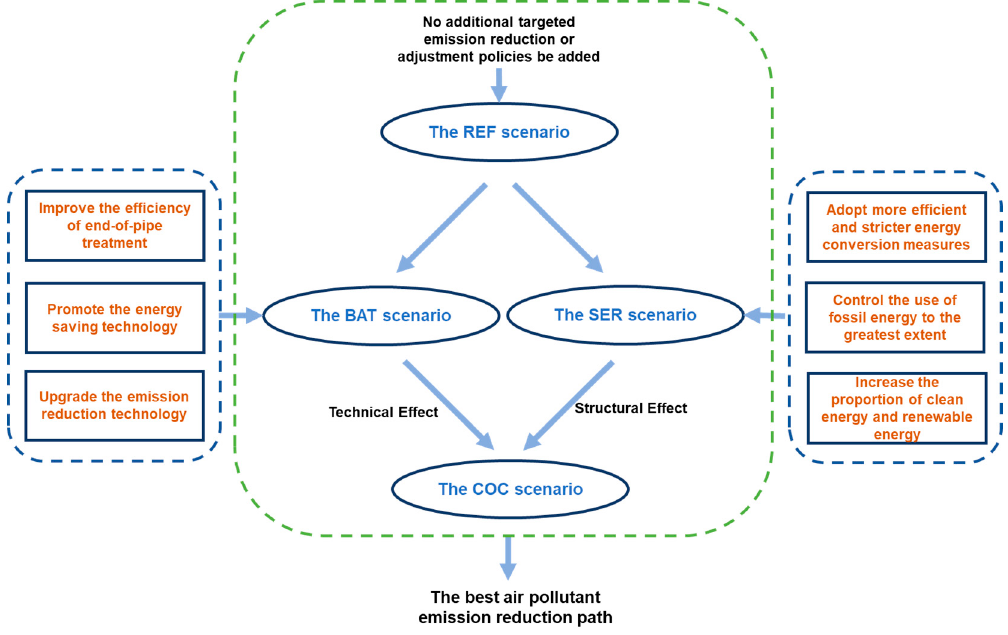
Figure 2. Flowchart of scenarios.